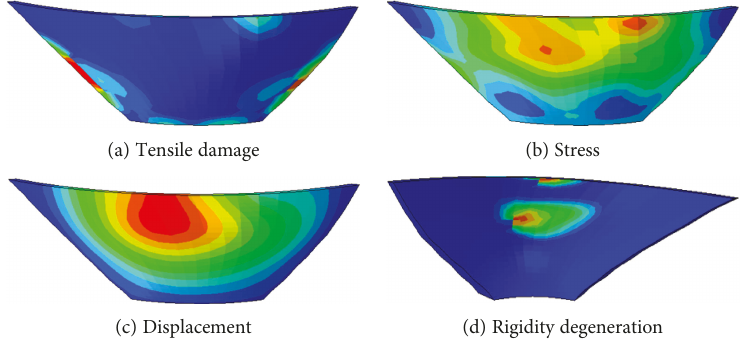
Figure 10: Dynamic response distribution of arch dam at t = 6 012 s .